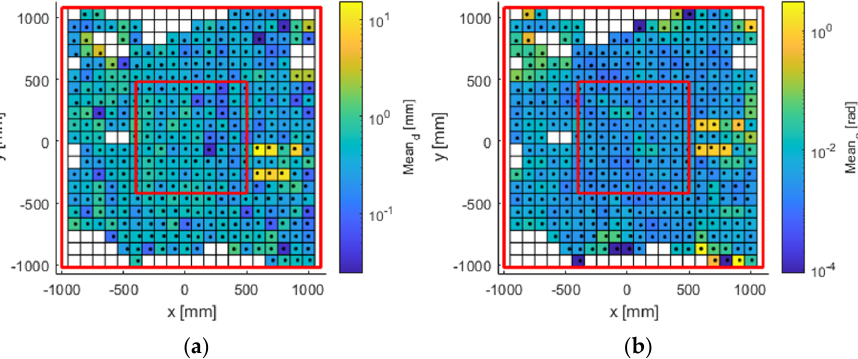
Figure 8. Mean error in ( a ) position (mm); and ( b ) orientation (rad). The available work area. The red lines delimit the large and inner areas.